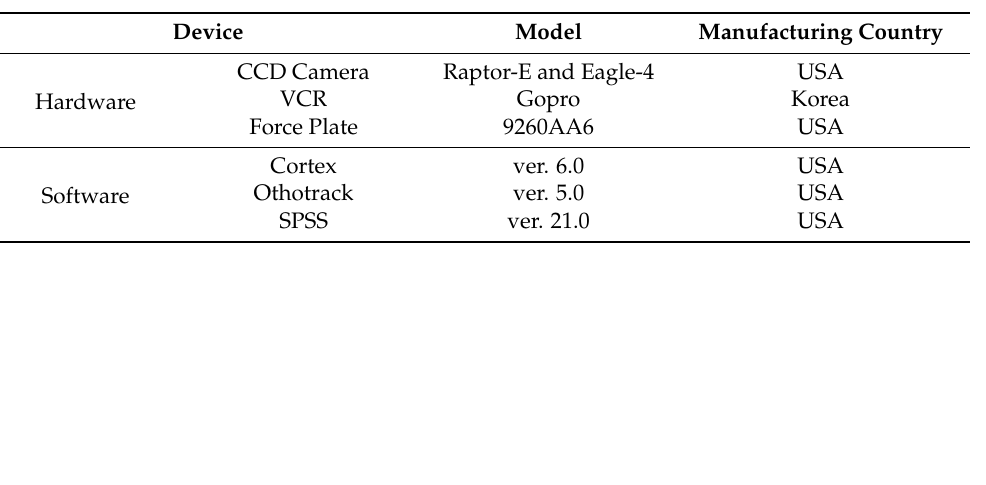
Table 1. Measuring device and analysis